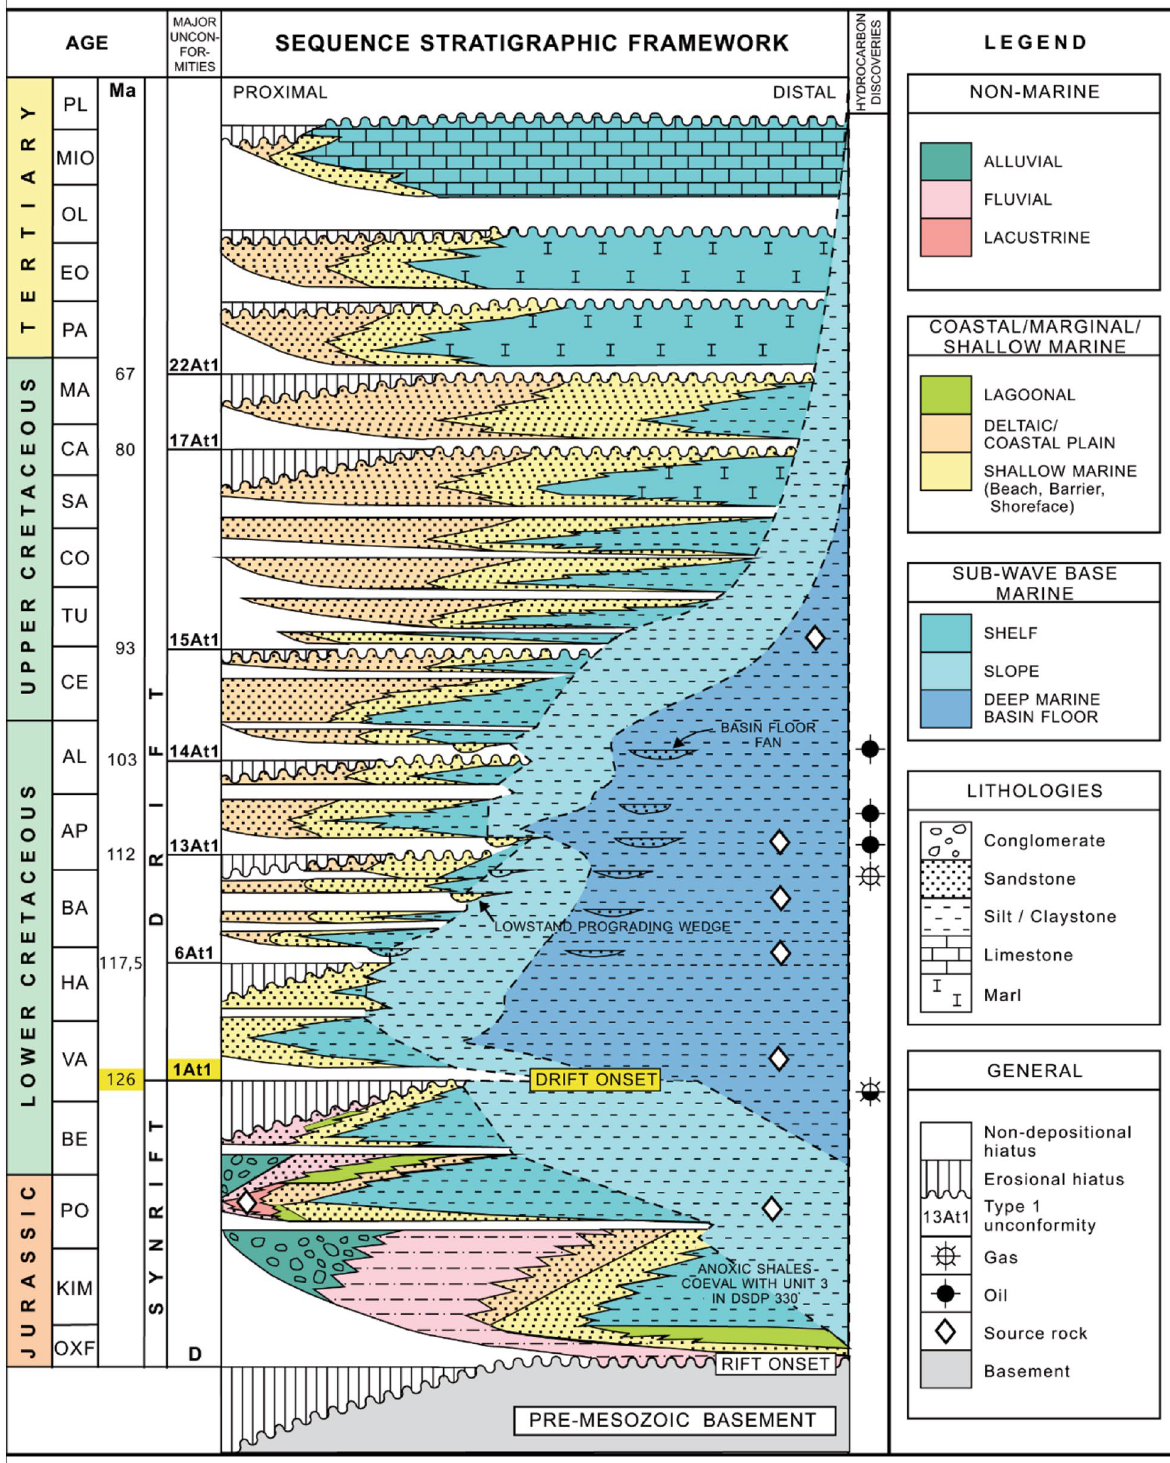
Figure 2. Stratigraphic nomenclature of sedimentary successions in South Africa’s Offshore Basins, modified after 29,32,33